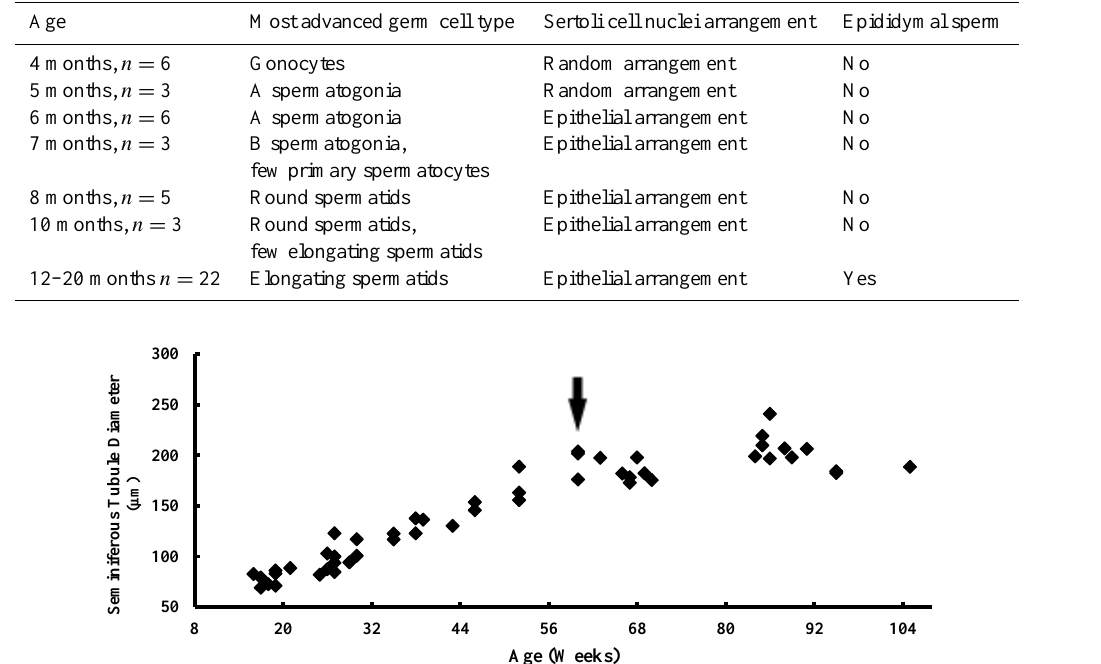
Figure 5. Mean individual seminiferous tubule diameter from 16 weeks onwards till 104 weeks in individual common marmosets ( n = 48). Increments in the mean tubule diameter until 60 weeks of age were statistically significant ( P < 0 . 05) as compared to the mean tubule diameter at 24 weeks of